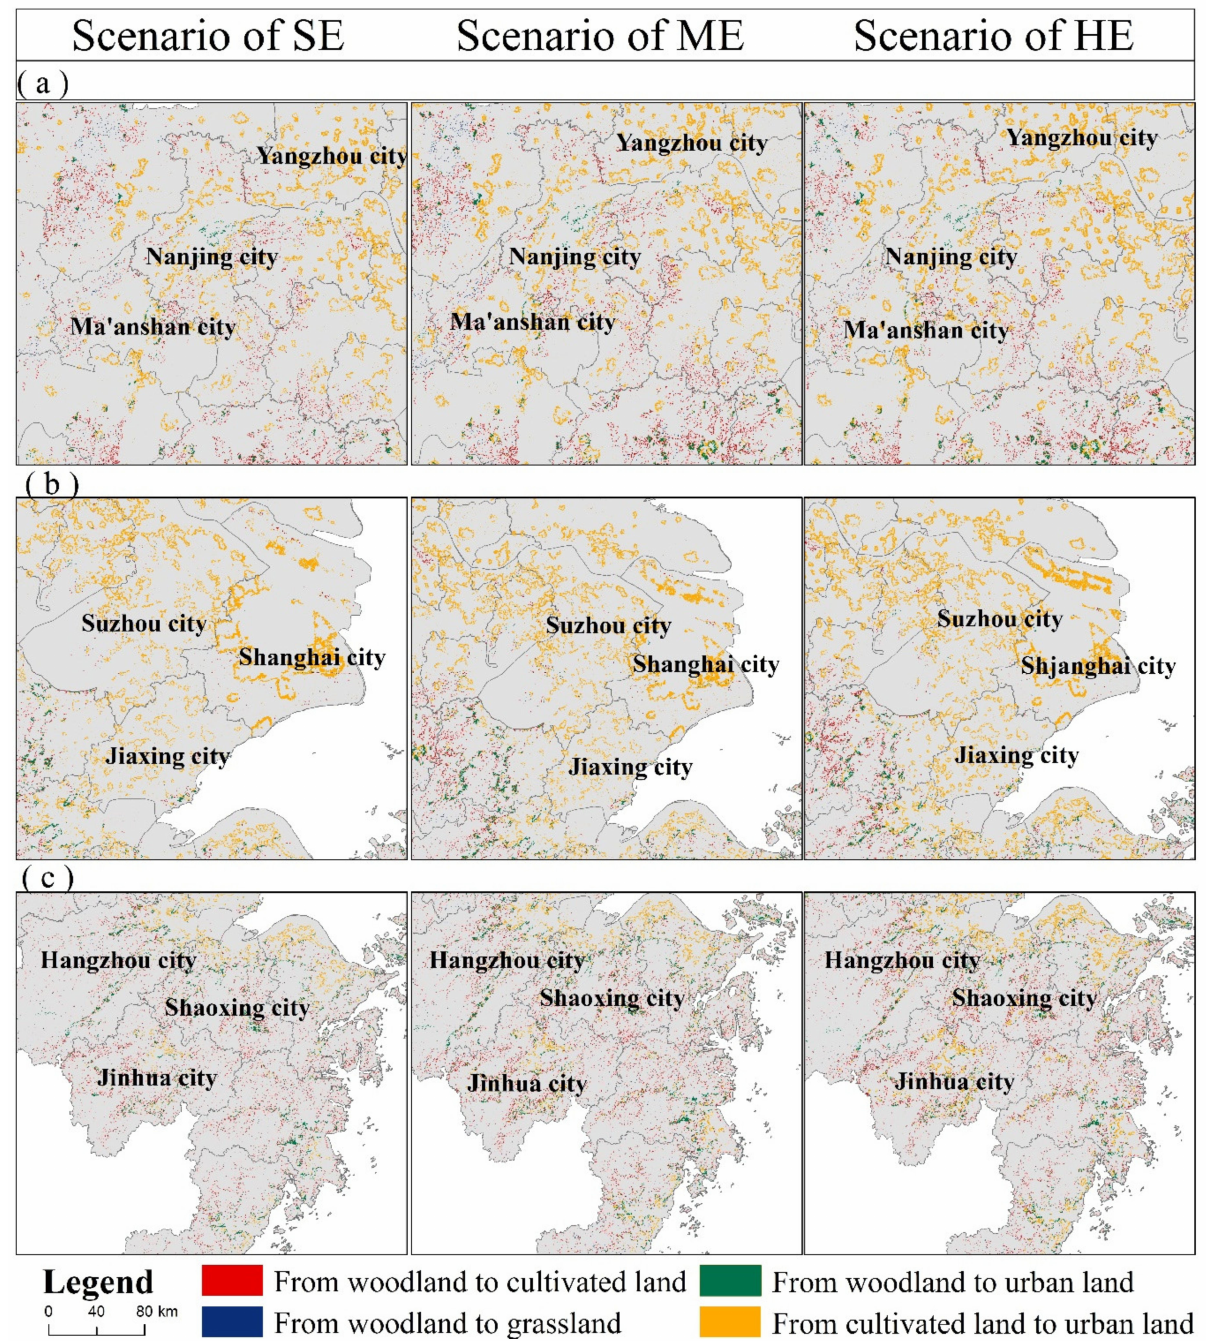
Figure 9. Spatial patterns of different causes of carbon storage loss from 2020 to 2035: ( a ) Nanjing, Maanshan, and Yangzhou; ( b ) Shanghai, Jiaxing, and Suzhou; ( c ) Hangzhou, Shaoxing, and